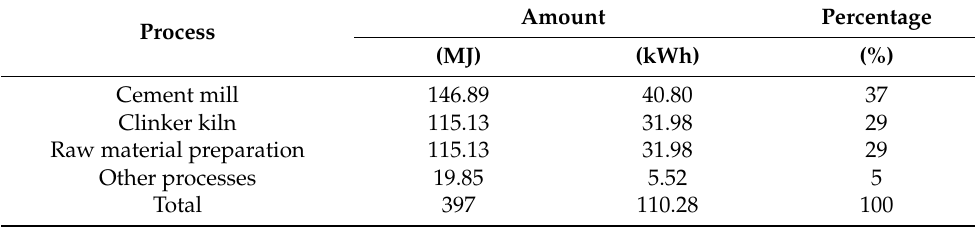
Table 4. Electrical energy consumption per ton of ordinary Portland cement (OPC) [22].